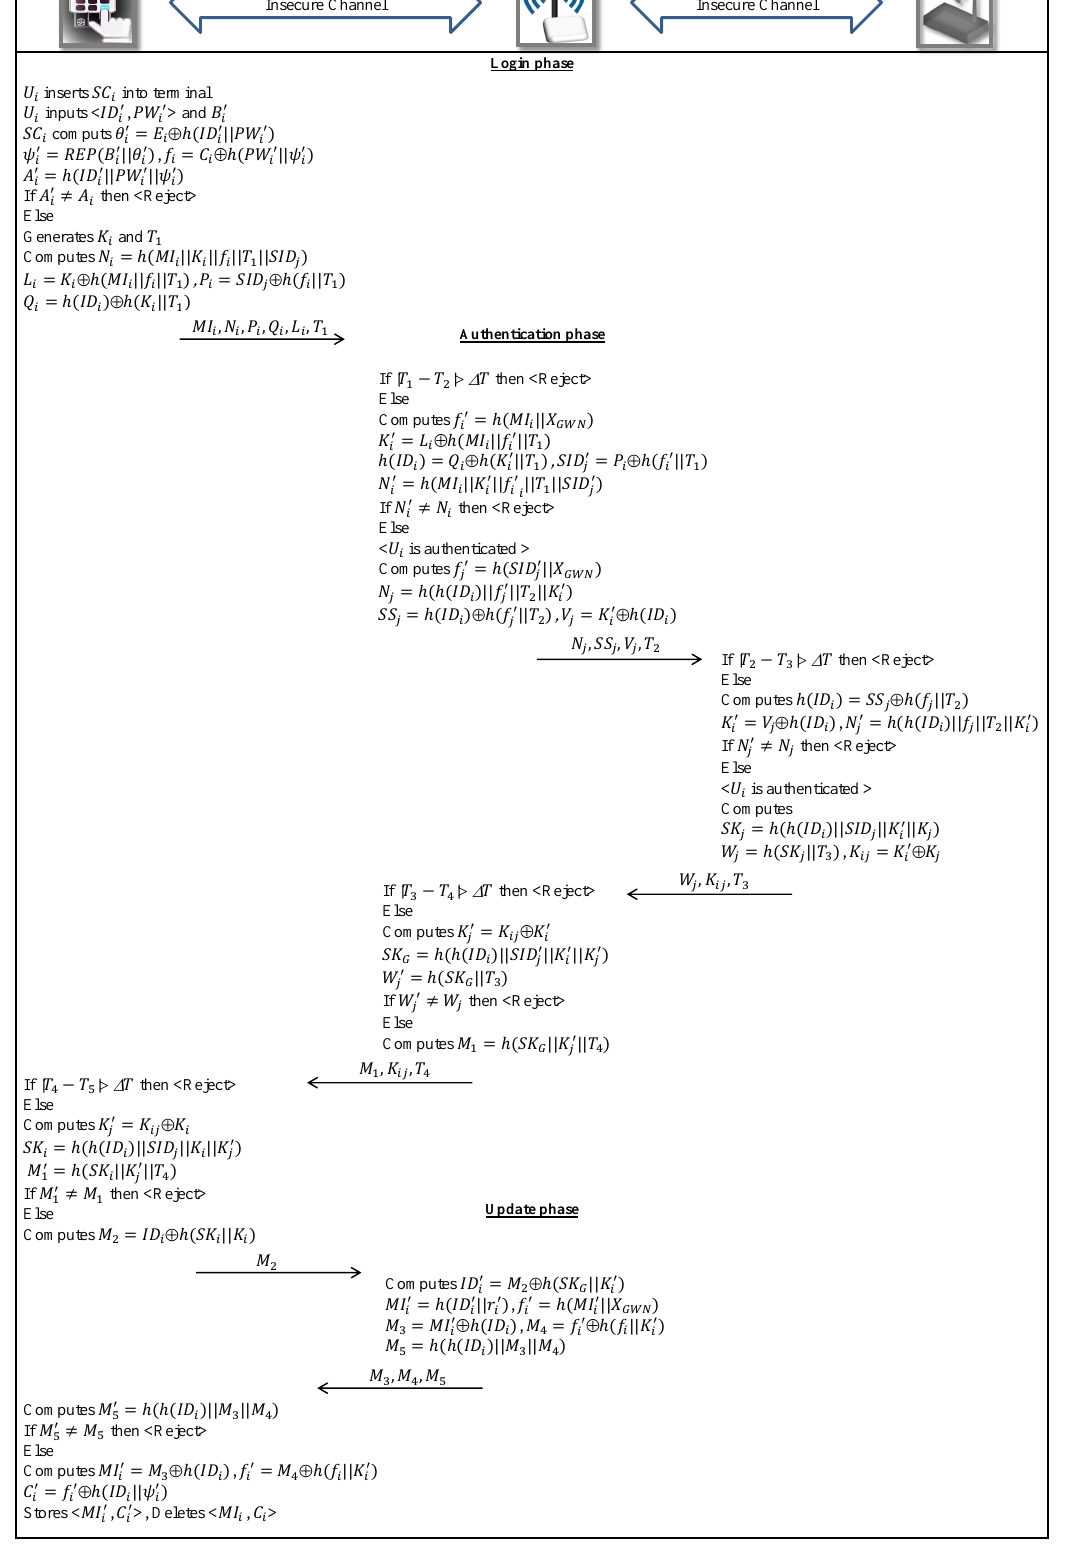
Figure 2. Authentication and key agreement phases in Amin et al.’s protocol